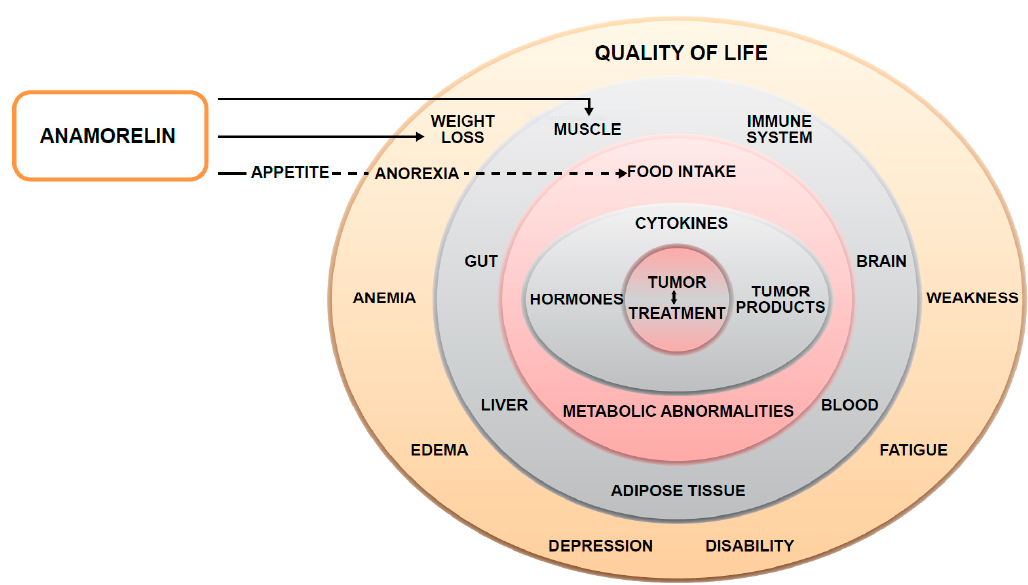
Figure 2. Schematic of the complex, multilayered, and multi-organ nature of cancer cachexia and the layers targeted by anamorelin in this process.